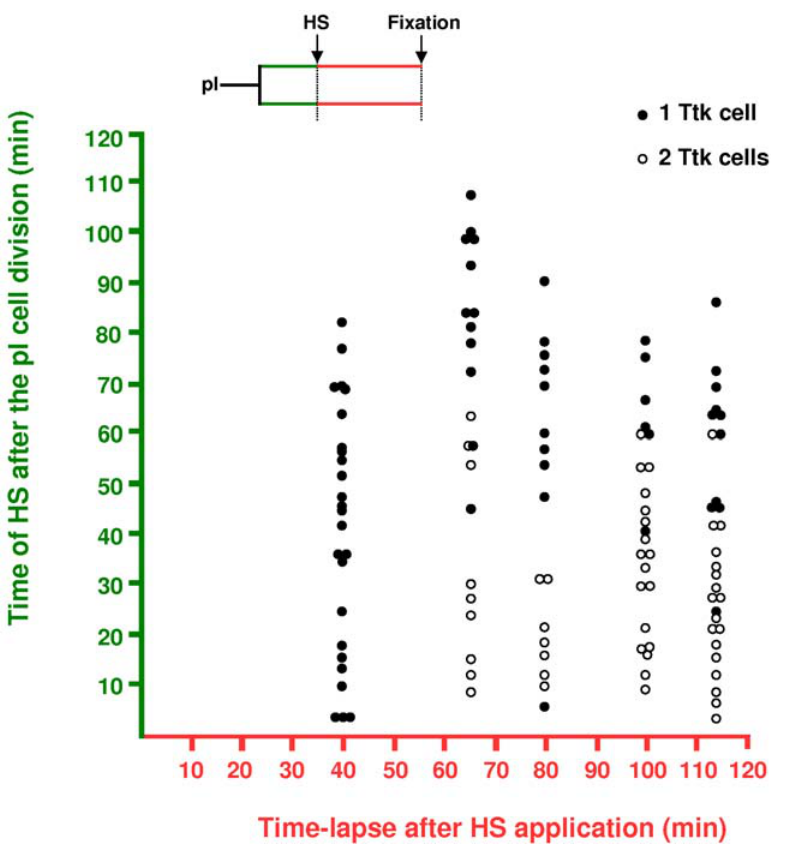
Figure 4. The probability to respond to the N pathway was related to the moment of N-expression rather than to the period required to implement the cellular response to Notch. Correlation between the moment of the N intra pulse (via a HS) after pI division (ordinate) and the time-lapse following N-activation (abscissa). The ectopic expression of Ttk in secondary anterior precursors was used to identify cell fate transformation (empty circles, both secondary precursor cells were Ttk positive). Filled circles correspond to no transformation (only one Ttk positive secondary precursor cell). Also note that the minimal time required to detect Ttk in the anterior cell was about 60 min. Note also that the transformation efficiency is higher when N intra pulses were applied during the first hour of life (empty dots are concentrated in the bottom half) independently of the time lapse after HS. hsN intra ; neu . H2B::YFP pupae.